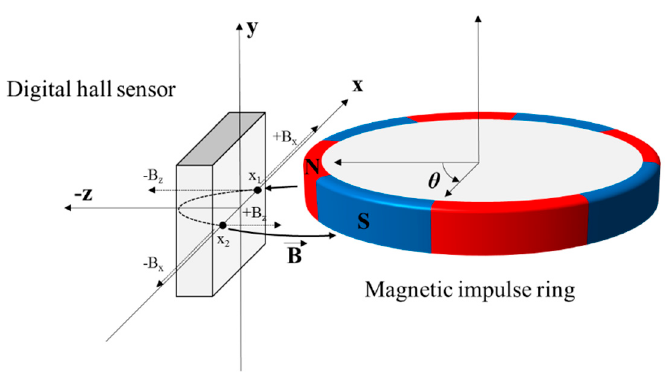
Figure 4. The principle of angle calculation between the hall sensor and magnetic impulse ring.